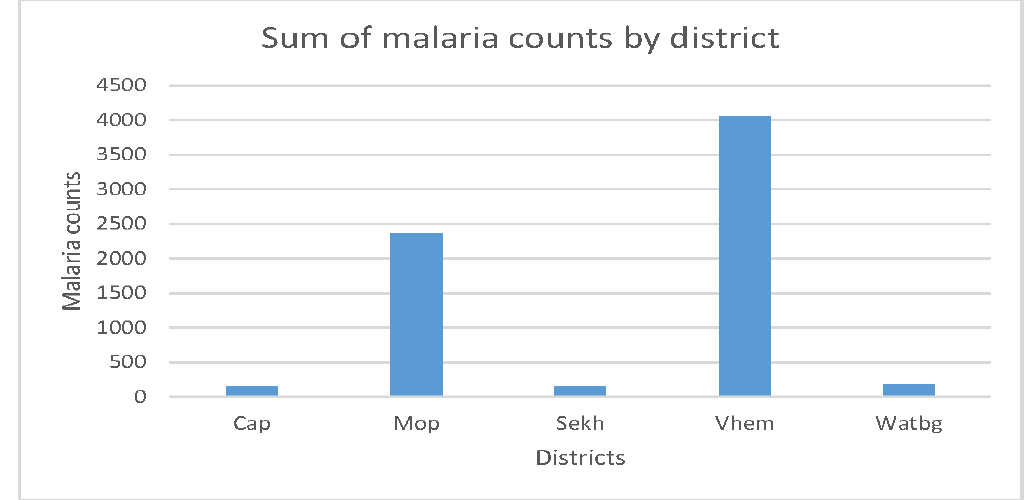
Figure 3. The distribution of malaria incidence across the districts of Limpopo province.